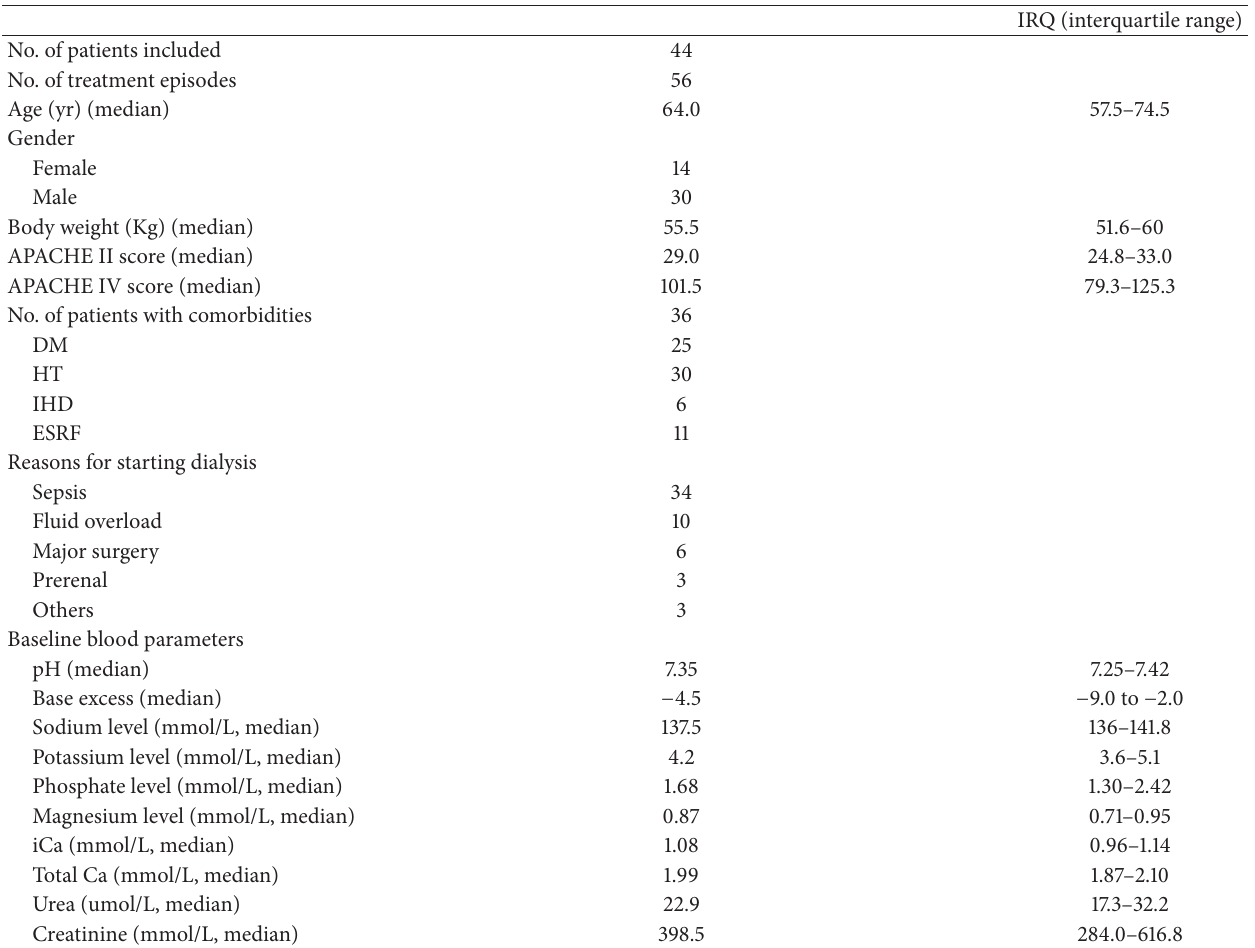
Table 1: Patients’ characteristics.